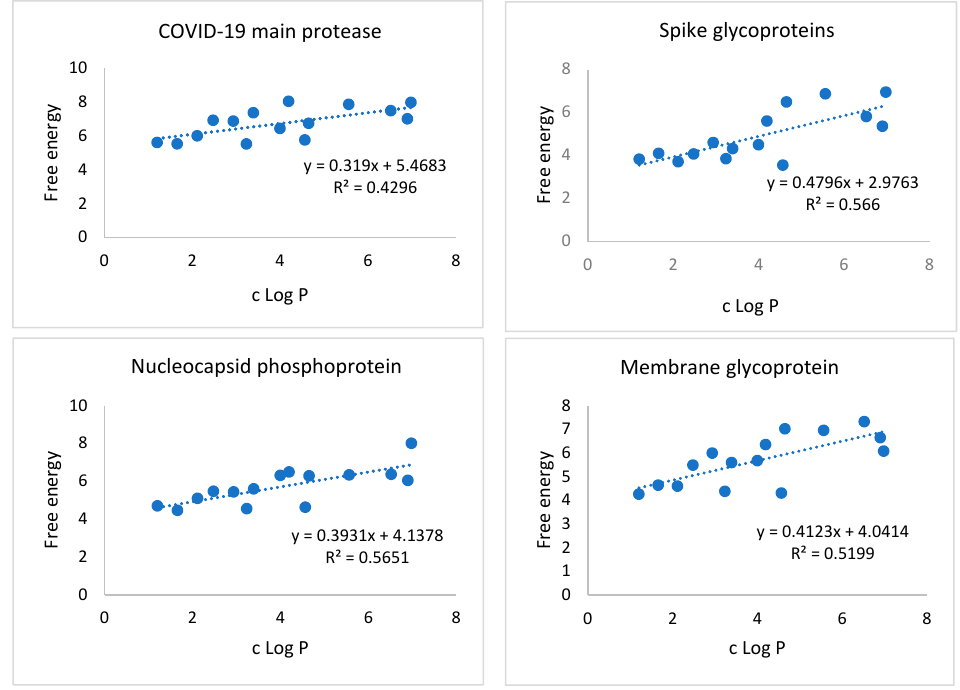
Figure 15. Correlation of c Log P with the free energy of binding against SARS-CoV-2 target proteins.